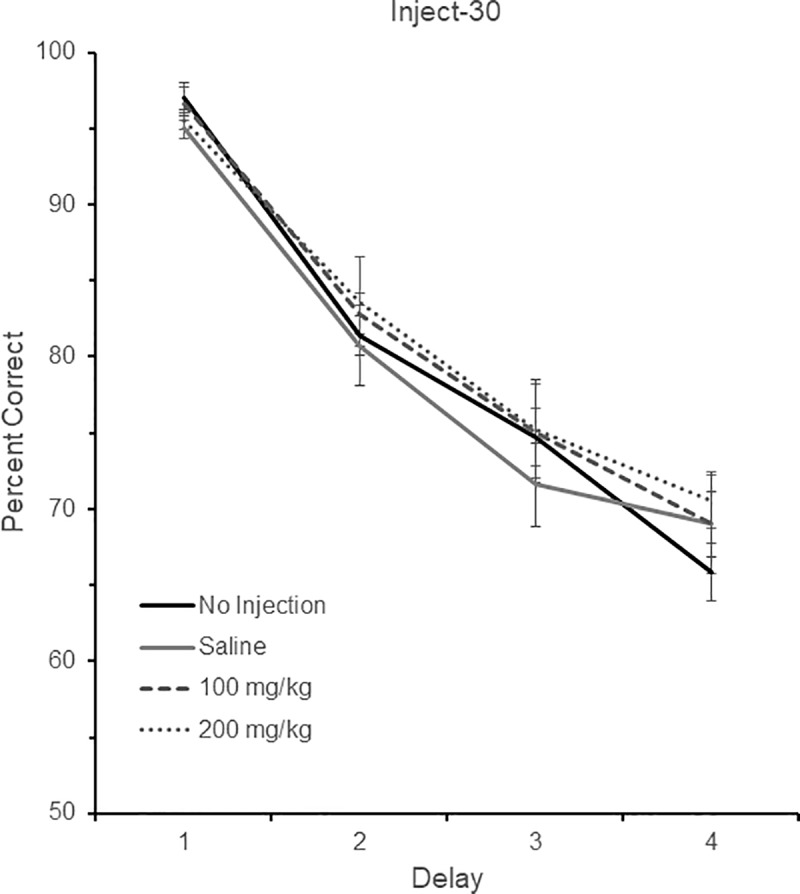
DMS performance in the Inject-30 condition.DMS performance following no injection, saline, 100 mg/kg aniracetam, and 200 mg/kg aniracetam in the Inject-30 condition. A total of six birds were tested. Three birds were tested with delays of 0, 2, 4, and 8 sec (Delay set 2), and three were tested with delays of 0, 3, 6, and 12 sec (Delay set 3). Chance is 50% correct. Error bars are +/- SEM.